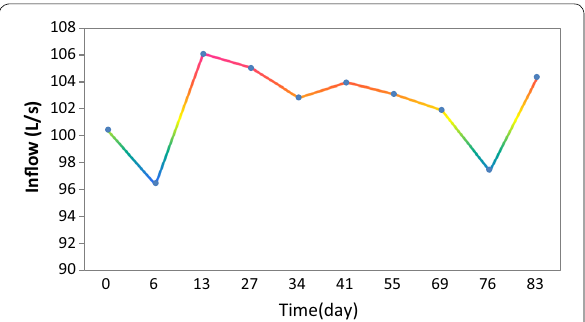
Fig. 2 Inflow of wastewater treatment plant during various days in the